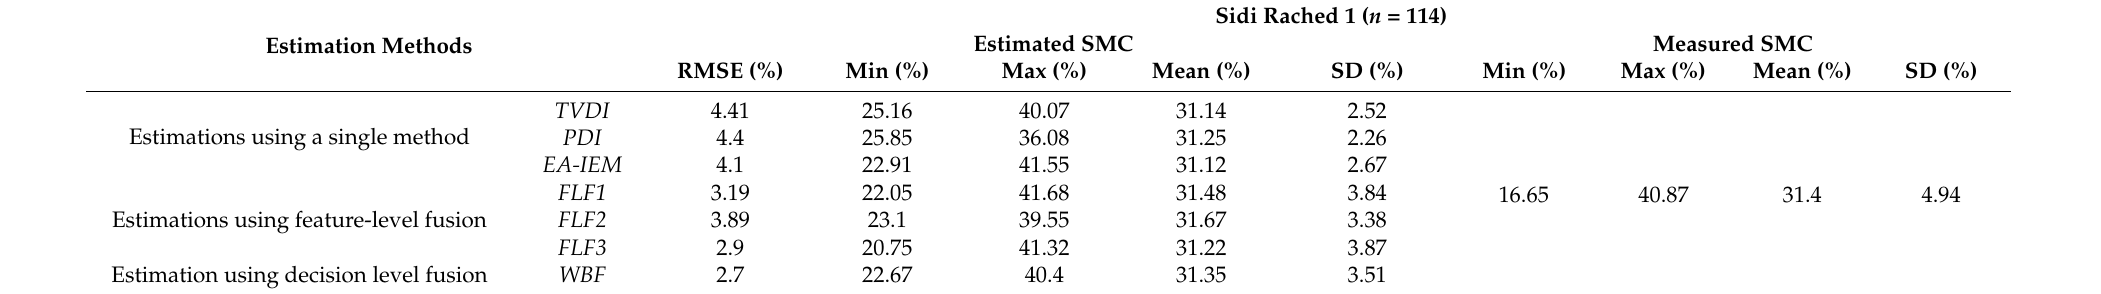
Table 8. The results of each of the used estimation methods in the Sidi Rached 1